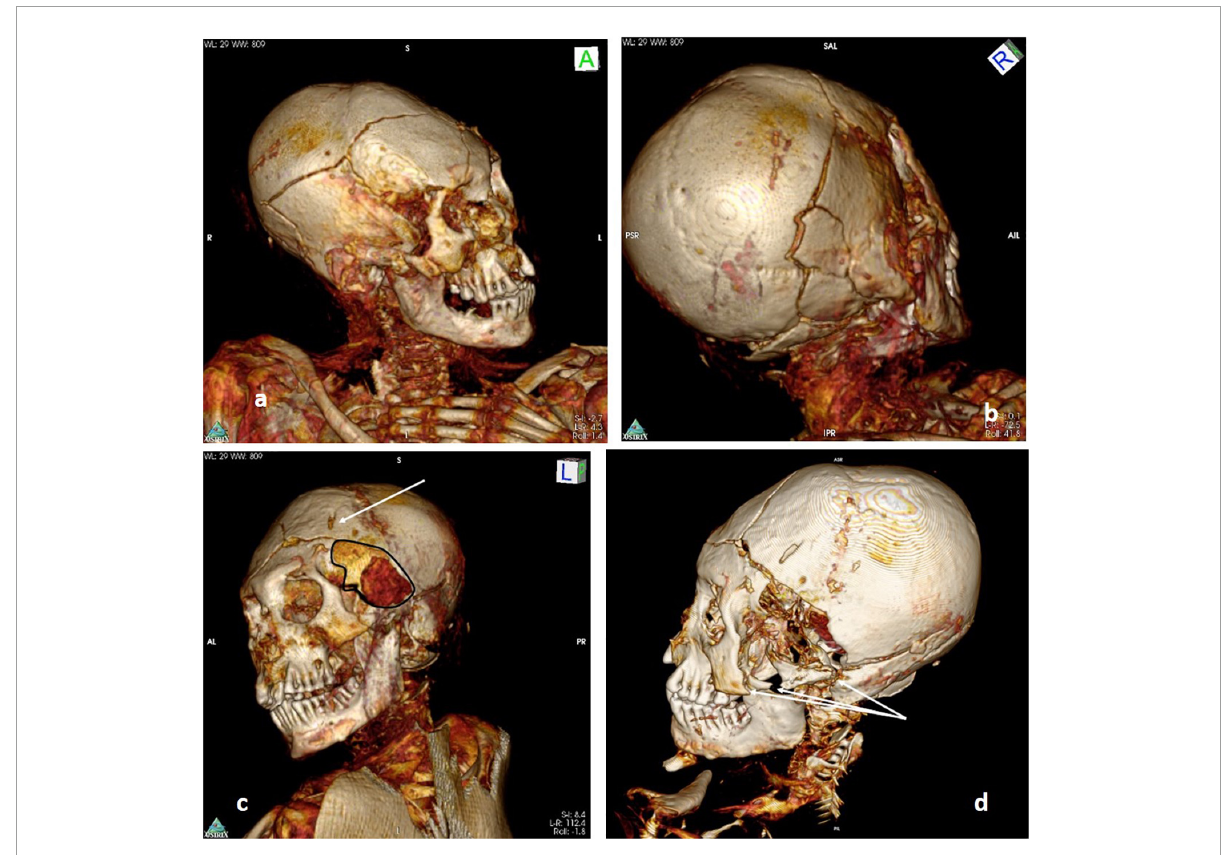
FIGURE9 (A–D) Features of perimortem skull trauma to the left side of the skull with a large perforating lesion at the left temporal region (arrow) and a fracture running into the skull. (D) Shows the zygoma’s fracture of the left side